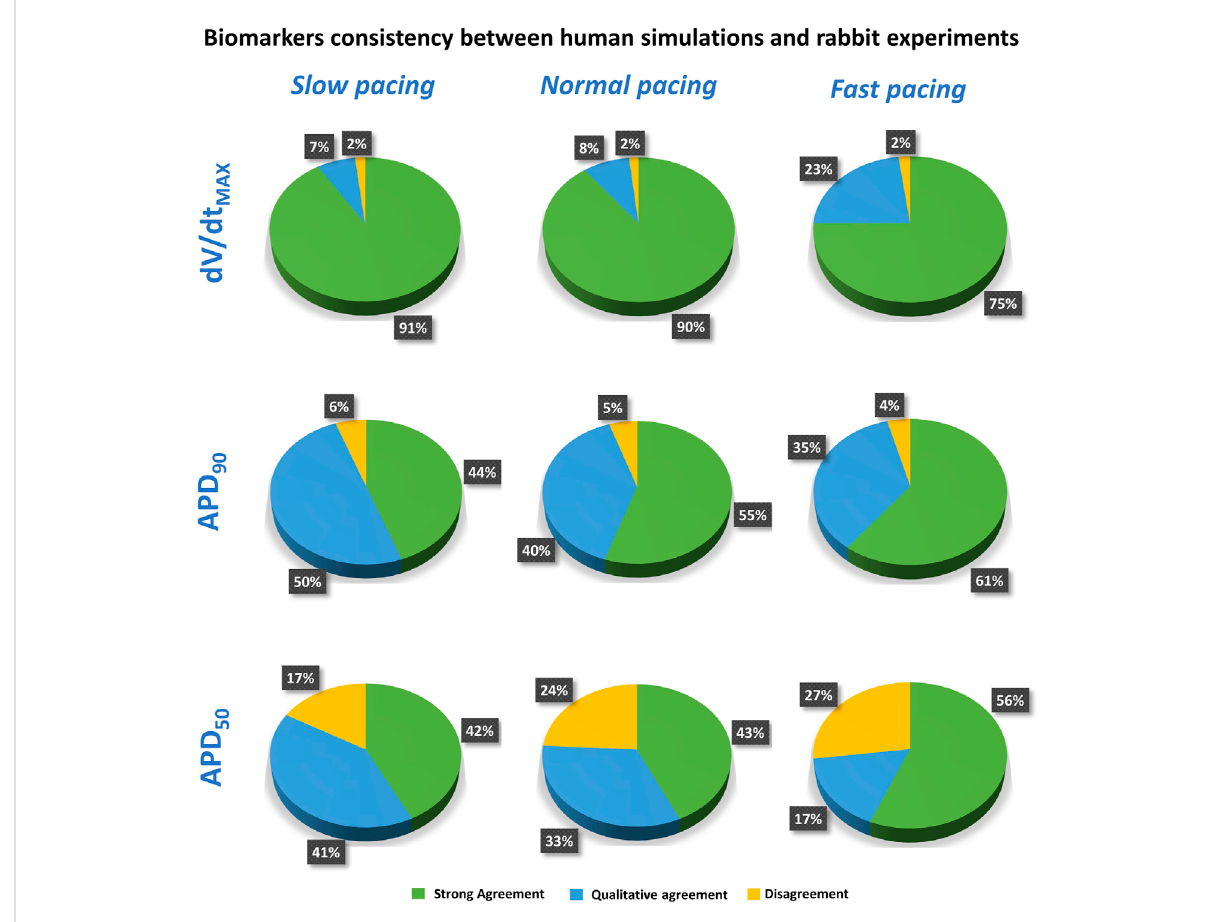
FIGURE 6 Summary of the comparison between experiments and simulations at different pacing frequencies, for dV/dt MAX (top), APD 90 (middle), and APD 50 (bottom). Pie charts show the percentage of tested compounds at different concentrations in strong agreement (green), qualitative agreement (blue), or disagreement (yellow). Categories de fi ned as in Section